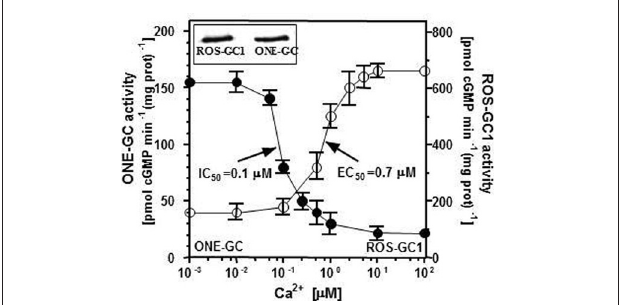
FIGURE 6 | Antithetical Ca 2 + modulated GCAP1 effect on ONE-GC and ROS-GC1 activities. Membranes of COS cells expressing ONE-GC or ROS-GC1 (control) were individually assayed for guanylate cyclase activity in the presence of 4 μ M GCAP1 and indicated concentrations of Ca 2 + . The experiment was carried out in triplicate and repeated three times. The results shown are shown are average ± SD from these experiments. The IC 50 and EC 50 values were determined graphically. Inset: Expression levels of ROS-GC1 and ONE-GC in COS cells were monitored by Western blot using antibodies against ROS-GC1 or